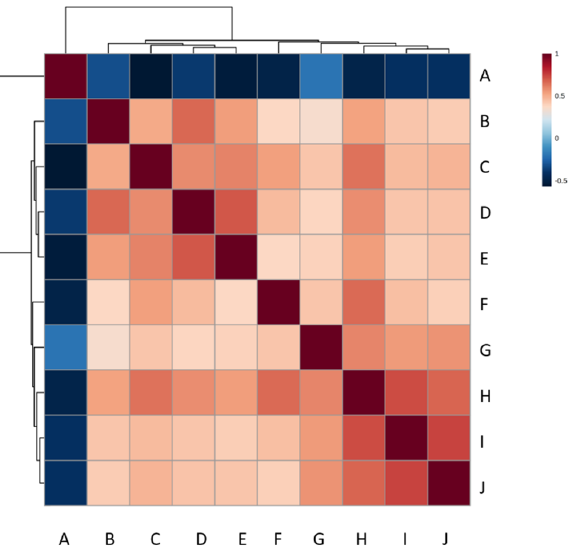
Figure 6. A heatmap of the Pearson’s correlation coefficients produced by comparing metabolites significantly affected by natural MAP infections and MAP-related antigens, whereby − 0.4 < correla- tion co-efficient > 0.4. Positive correlations are shown in red, negative correlations are shown in blue. A = LPA (18:2 (9Z,12Z)/0:0), B = p-cresol, C = Hippuric acid, D = Eicosapentaenoic acid, E = Phytanic acid, F = WAG31, G = TOP4, H = MAP1693, I = MAP0211, J = MAP0946.